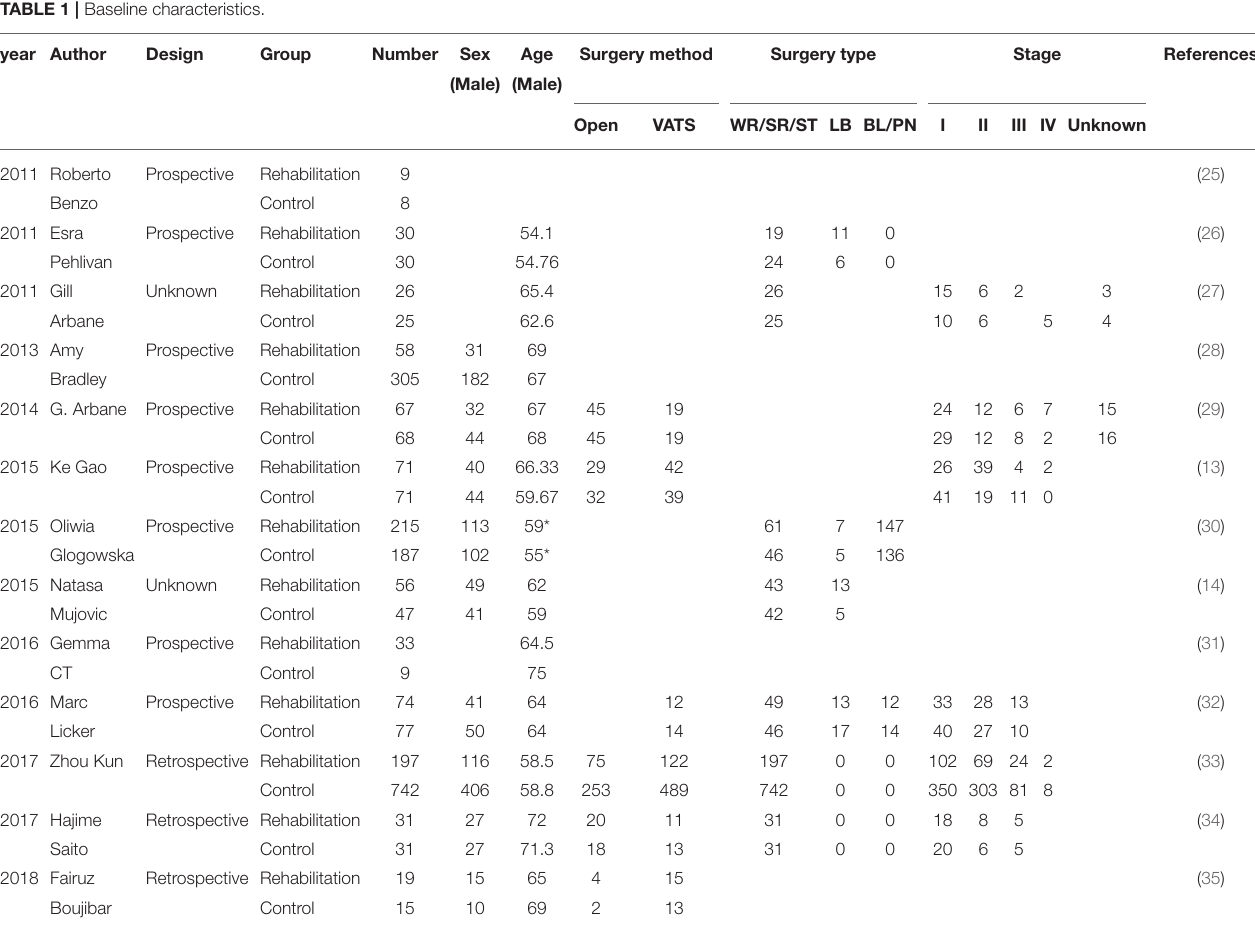
FIGURE 1 | The flow chart of the publication selection. TABLE 1 | Baseline